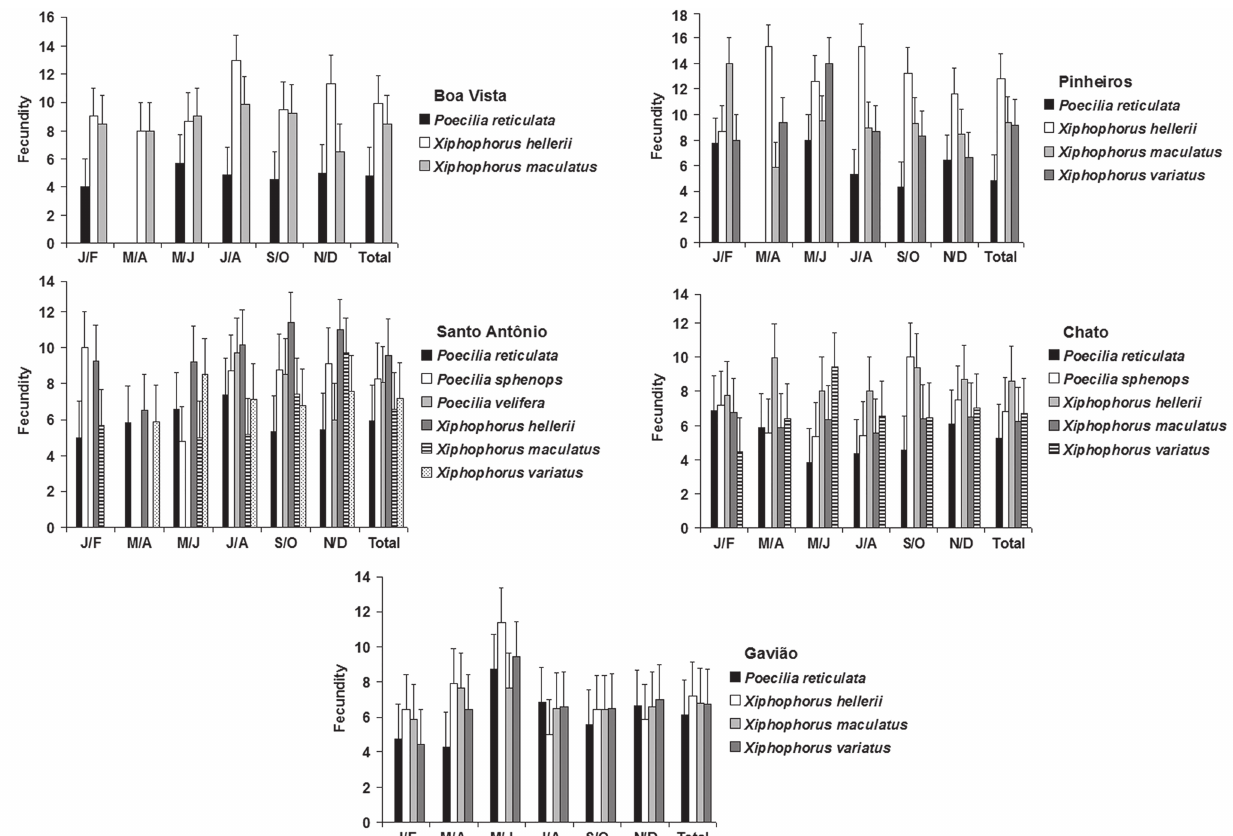
Fig. 7. Bimonthly and total fecundity (number of embryos per brood) of ornamental non-native poeciliid species collected in the creeks in 2003, 2004, 2005 and 2006. Tab. 3. Bimonthly and total sex ratio of ornamental non-native poeciliid species collected in the creeks in 2003, 2004, 2005 and 2006. * Indicates the significant values for sex ratio (Chi-square, P < 0.05, χ 2 Species/Sex